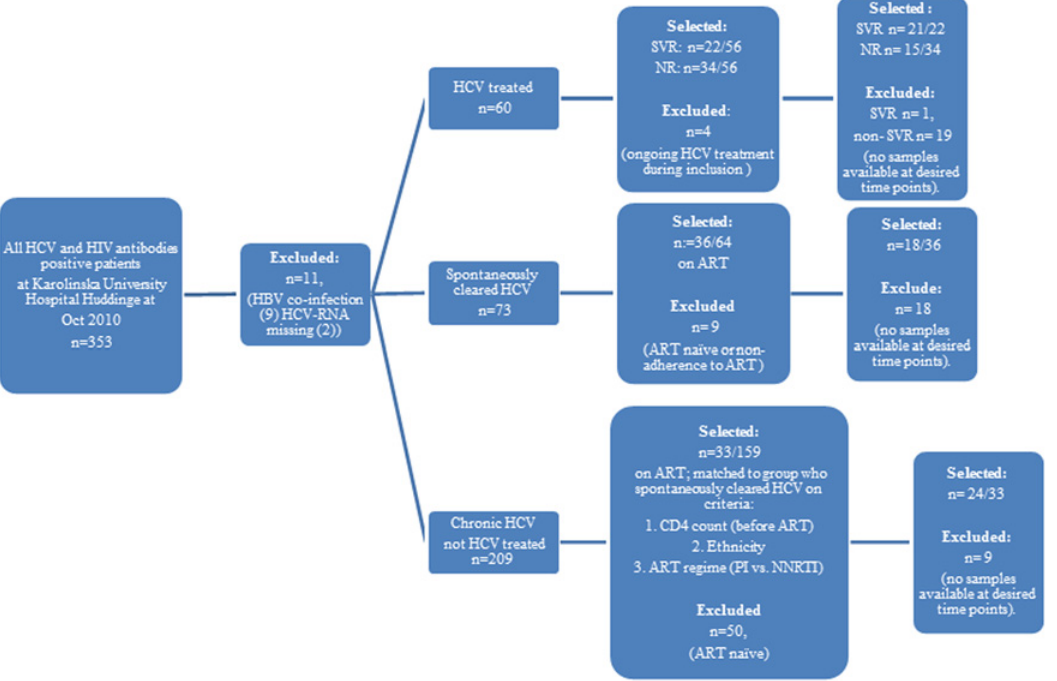
Fig 1. Cohort inclusion and exclusion criteria. Abbreviations: Sustained viral responders (SVR), Non-responders (NR), Human immunodeficiency virus type 1 (HIV-1), Hepatitis C virus (HCV), Hepatitis B virus (HBV), antiretroviral therapy (ART). Non-Nucleoside Reverse Transcriptase Inhibitors (NNRTIs), Protease Inhibitors